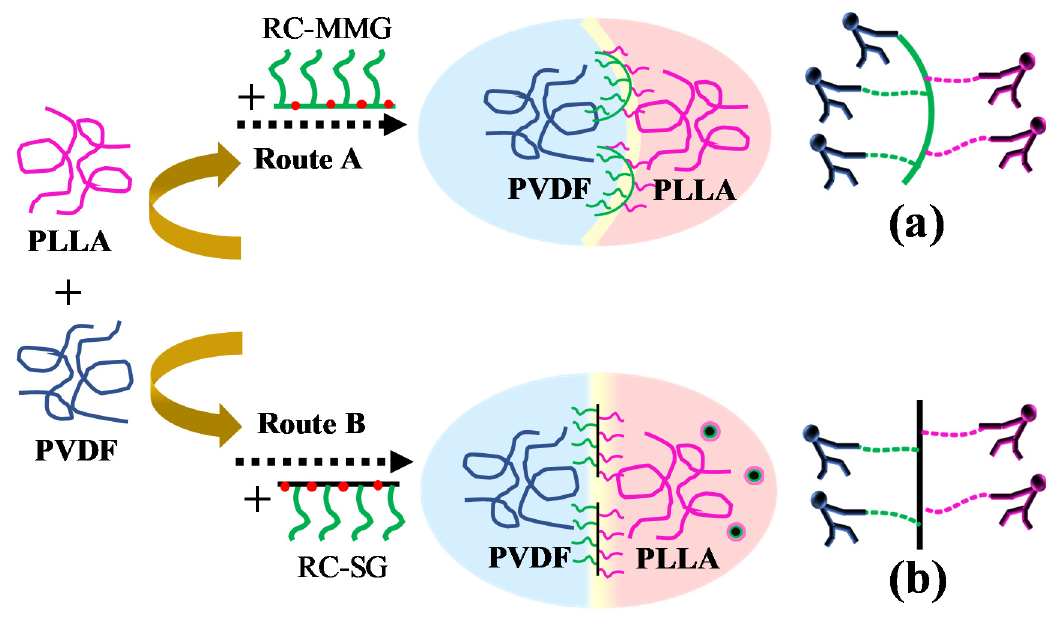
Scheme 2. Schematic diagrams of the compatibilization mechanism of PVDF/PLLA blend by